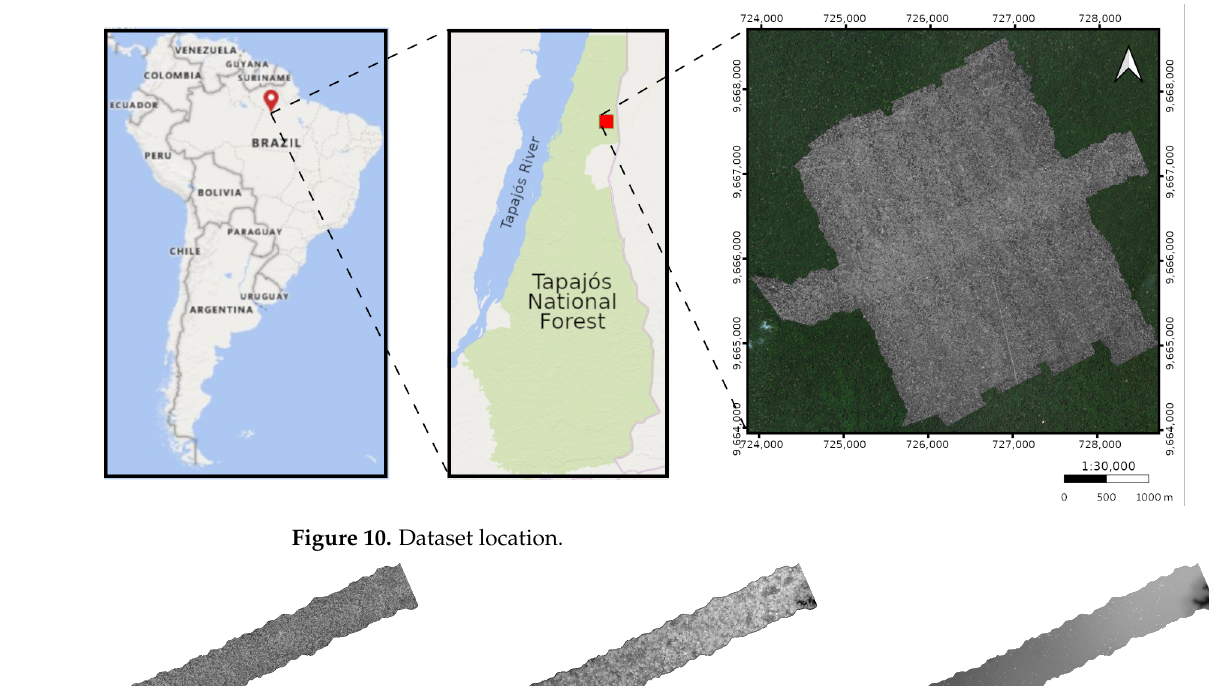
Figure 10. Dataset location.